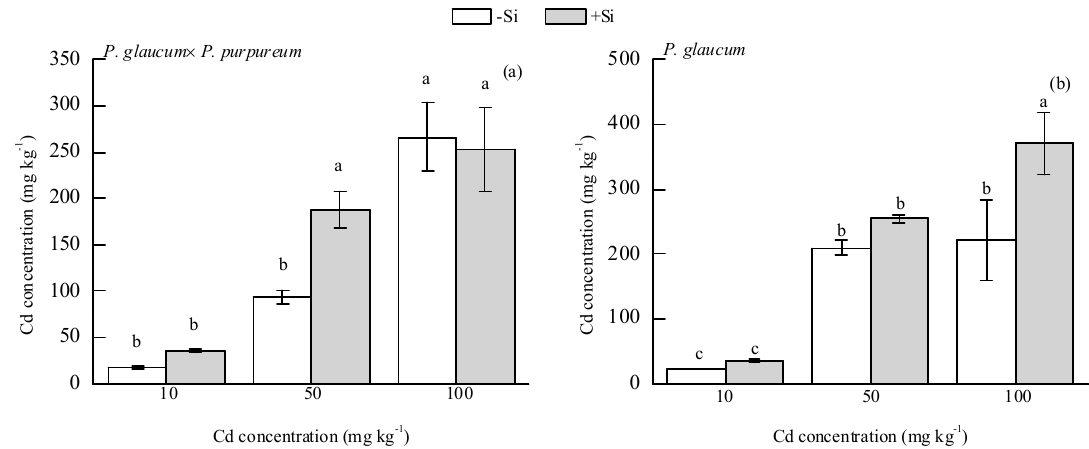
Figure 3. E ff ect of Si on soil total Cd concentration of ( a ) P. glaucum × P. purpureum and ( b ) P. glaucum . Values are mean ± SE ( n = 3). Values followed by the di ff erent letters indicate significant di ff erences between di ff erent treatments of the same variety, according to one-way ANOVA followed by the Duncan test ( p < 0.05).